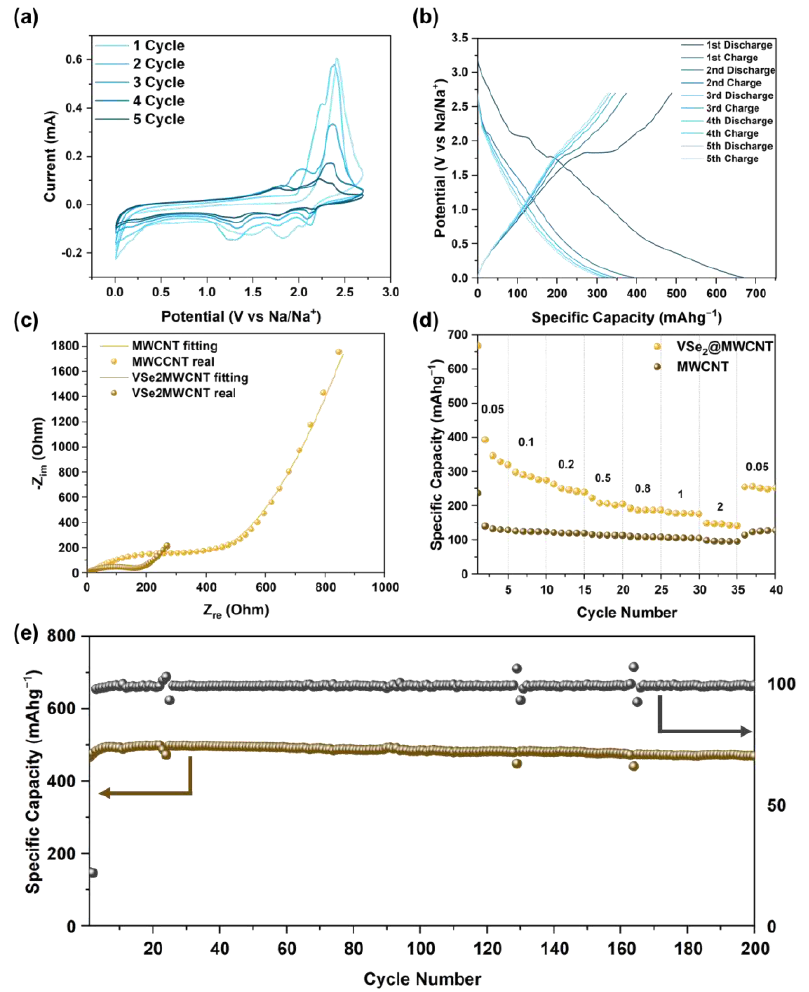
Figure 4. Electrochemical properties over a voltage window between 0.01 to 2.7 V versus Na/Na + ( a ) Cyclic voltammetry at a scan rate of 1 mVs − 1 of VSe 2 @MWCNT and ( b ) charge/discharge curve at a current density of 0.05 Ag −1 of VSe 2 @MWCNT. ( c ) electrochemical impedance spectroscopy diagram and ( d ) rate capabilities at different current densities of MWCNT and VSe 2 @MWCNT. ( e ) cycling performance and coulombic efficiency of VSe 2 @MWCNT at a current density of 0.01 Ag − 1 . Table 1. Comparison of electrochemical performance of different kinds of binder-free electrode ma- terials.